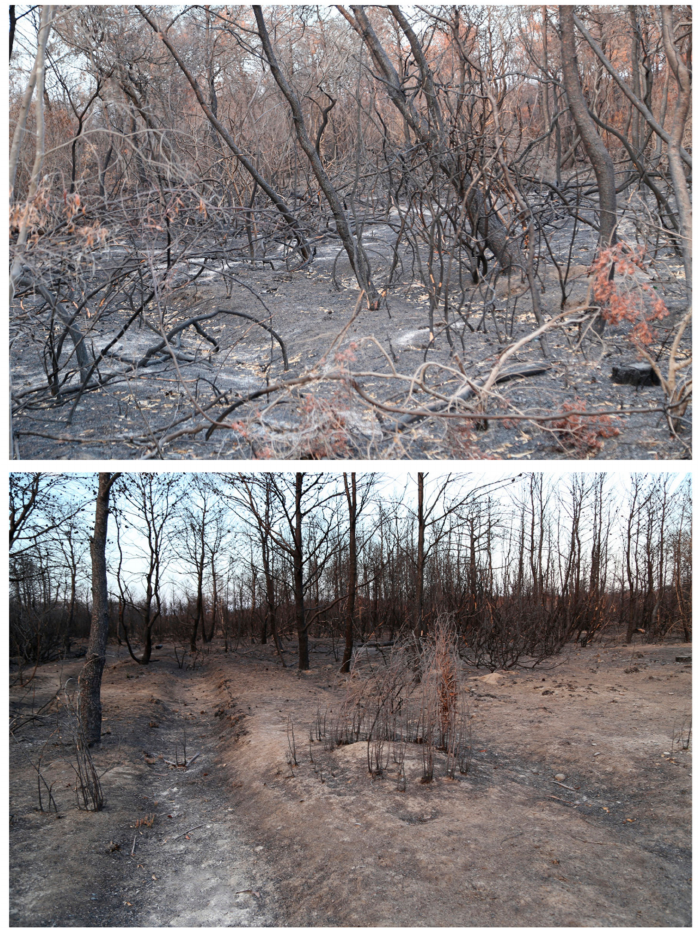
Figure 4. Field survey post-fire event in the pine forest area at Metaponto (Author: Dr. R.